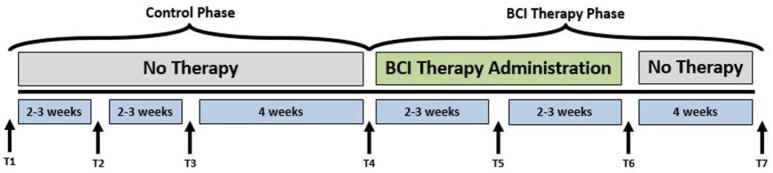
Study paradigm. The time-points at which neuroimaging data were collected are represented by: T1: Control baseline 1, T2: Control baseline 2, T3: Control baseline 3, T4: Therapy baseline T5: Mid-therapy, T6: Post-therapy, and T7: 1-month post-therapy. While the crossover control group completed visits T1 through T7, the BCI therapy group completed visits T4 through T7 only.